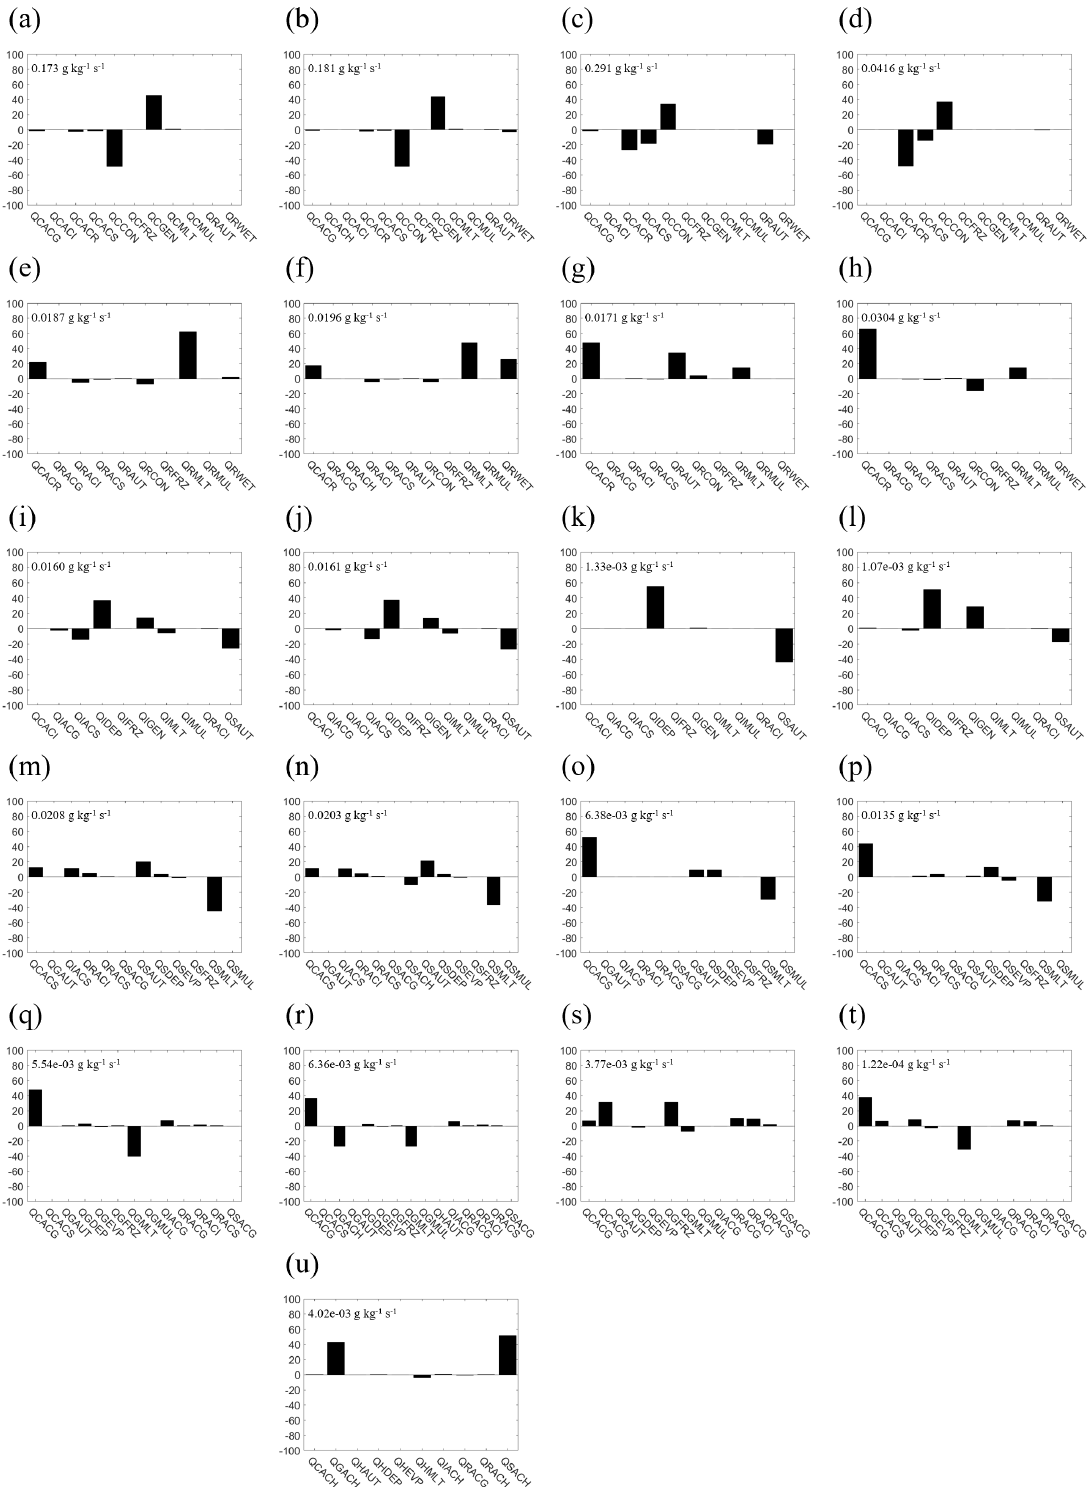
Figure 13. The same as Fig. 9 but representing the results for case 7.